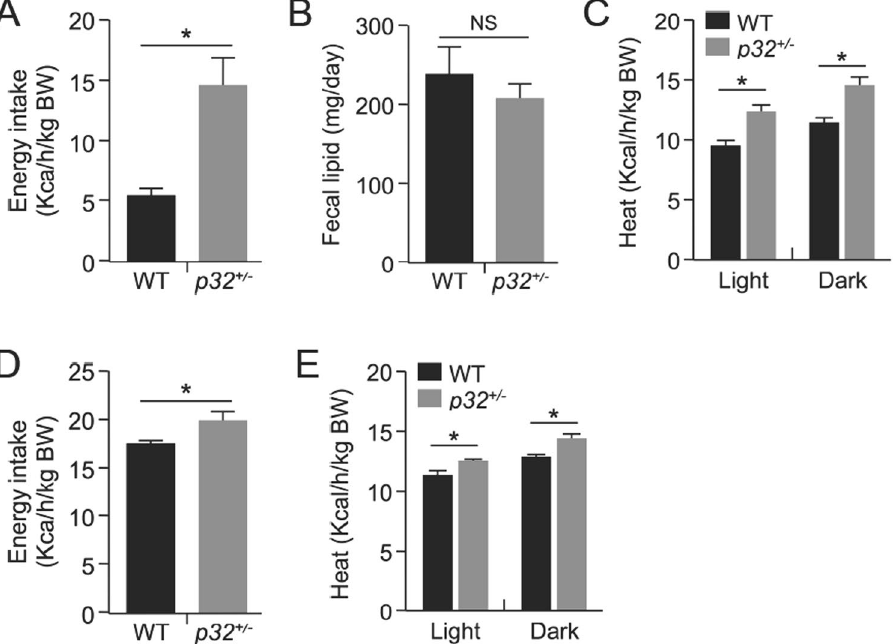
Figure 4. p32 + / − mice demonstrate increased caloric intake and energy expenditure. ( A ) Caloric intake in 52-week-old mice fed NC (n = 5). Caloric intake is normalized to body weight. ( B ) Fecal lipid excretion in 52-week-old mice fed NC (n = 5). ( C ) Heat release in 52-week-old mice fed NC (n = 3). ( D ) Caloric intake in mice fed an HFD (WT, n = 7; p32 + / − , n = 5). Caloric intake is normalized to body weight. ( E ) Heat release in WT and p32 + / − mice fed an HFD for ten weeks (n = 3). Statistical comparisons were evaluated by two-way- ANOVA for the indirect calorimetry